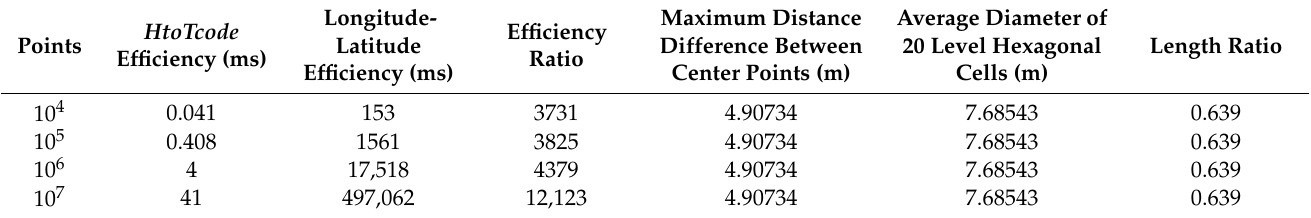
Table 16. Comparison of efficiency and accuracy of HtoTcode and longitude–latitude expressing discrete